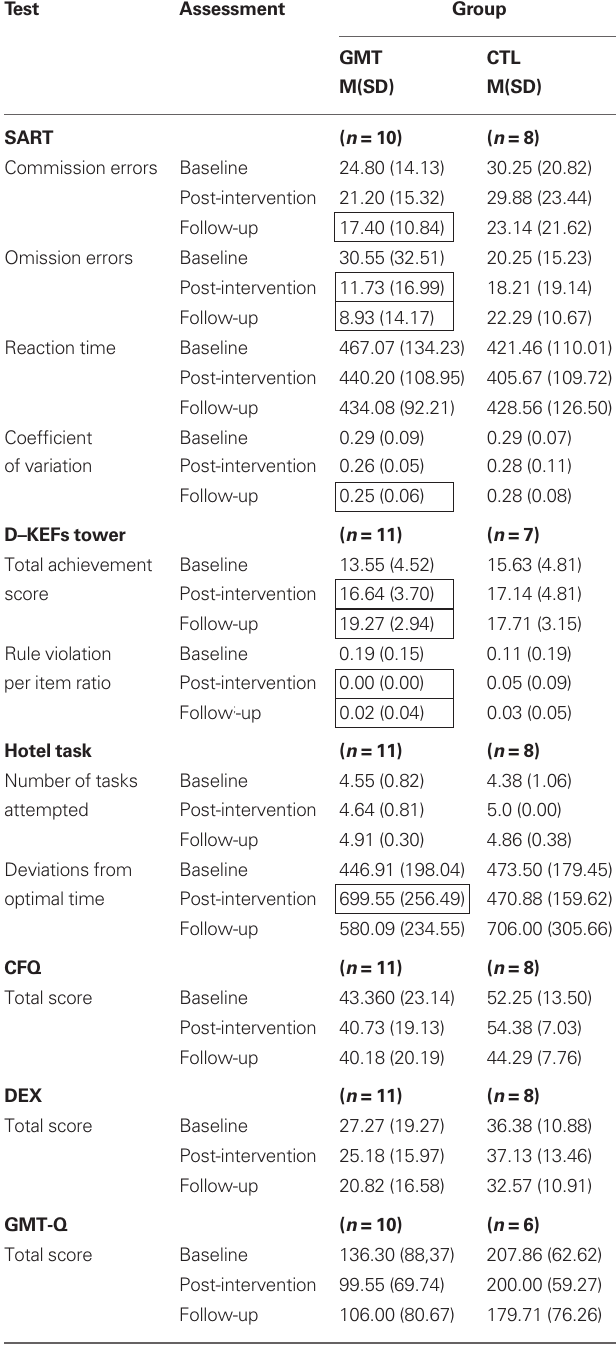
Table 3 | Outcome